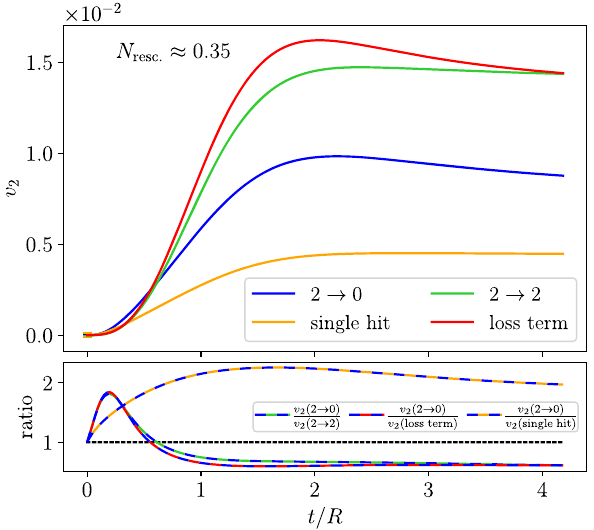
ε = 0 . 15 and on average N ≈ 0 . 35 rescatterings per particle, in 2 resc . systemsThegreencurvesareforsystemswithelasticbinaryscatterings, the blue lines for the 2 → 0 scenario, the orange ones for the single-hit model, and the red lines show the analytical result